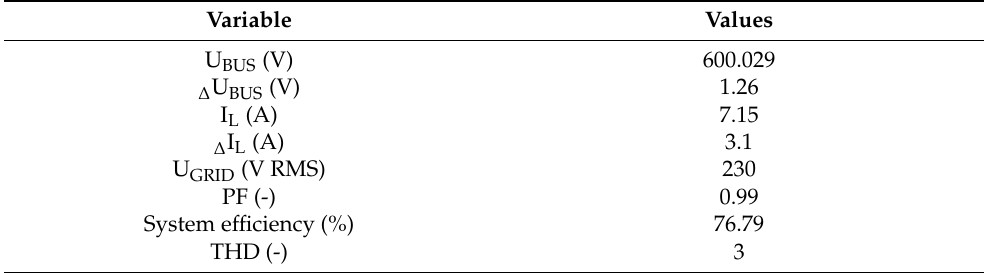
Table 3. Evaluation of the operational variables of the proposed DC microgrid during Scenario